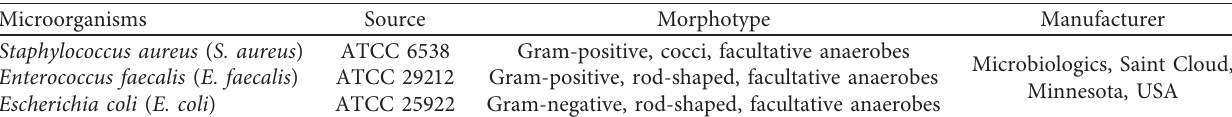
Table 2: Bacterial strains used as indicators of antimicrobial activity, their source and morphotype. Microorganisms